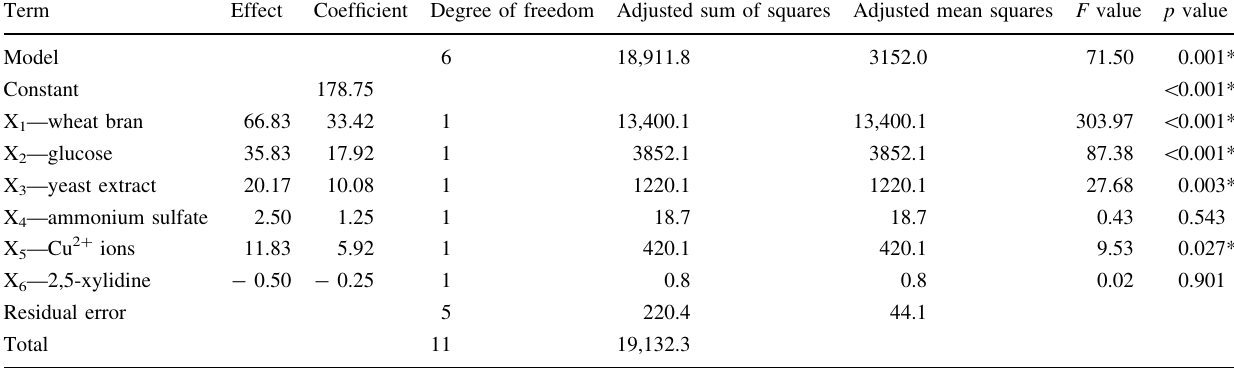
Table 4 Regression coefficient and analysis of variance for the quadratic model for laccase production